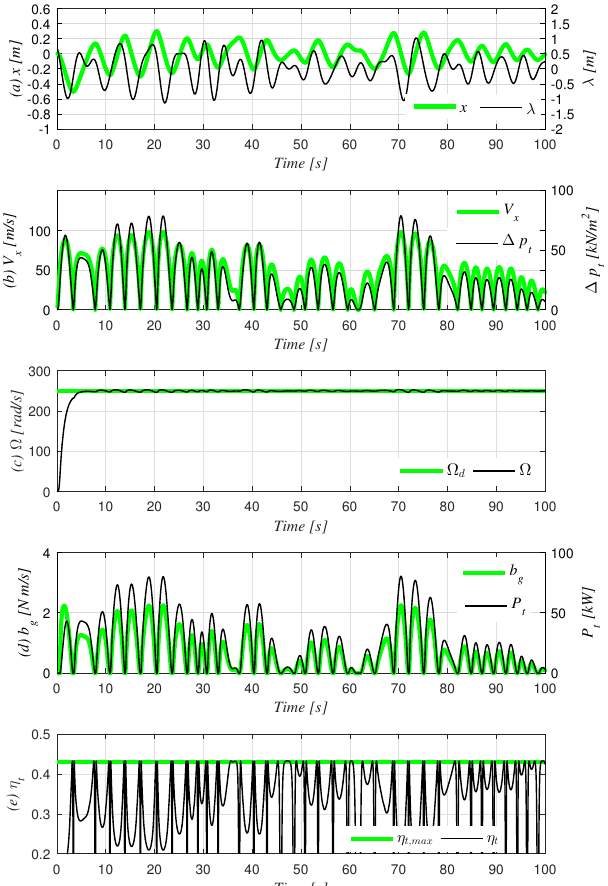
Figure 8. Simulation result of the first 100 s with the CAV controller when Ω d = 250 rad/s and k p = 1: ( a ) wave λ and water column positions x ; ( b ) airflow speed at the turbine duct V x and pressure drop across the turbine ∆ p t ; ( c ) turbine rotor angular velocity Ω and its desired value Ω d ; ( d ) generator damping coefficient (control input) b g and power extraction from the turbine P t ; ( e ) turbine efficiency η t and its maximum value η t , max